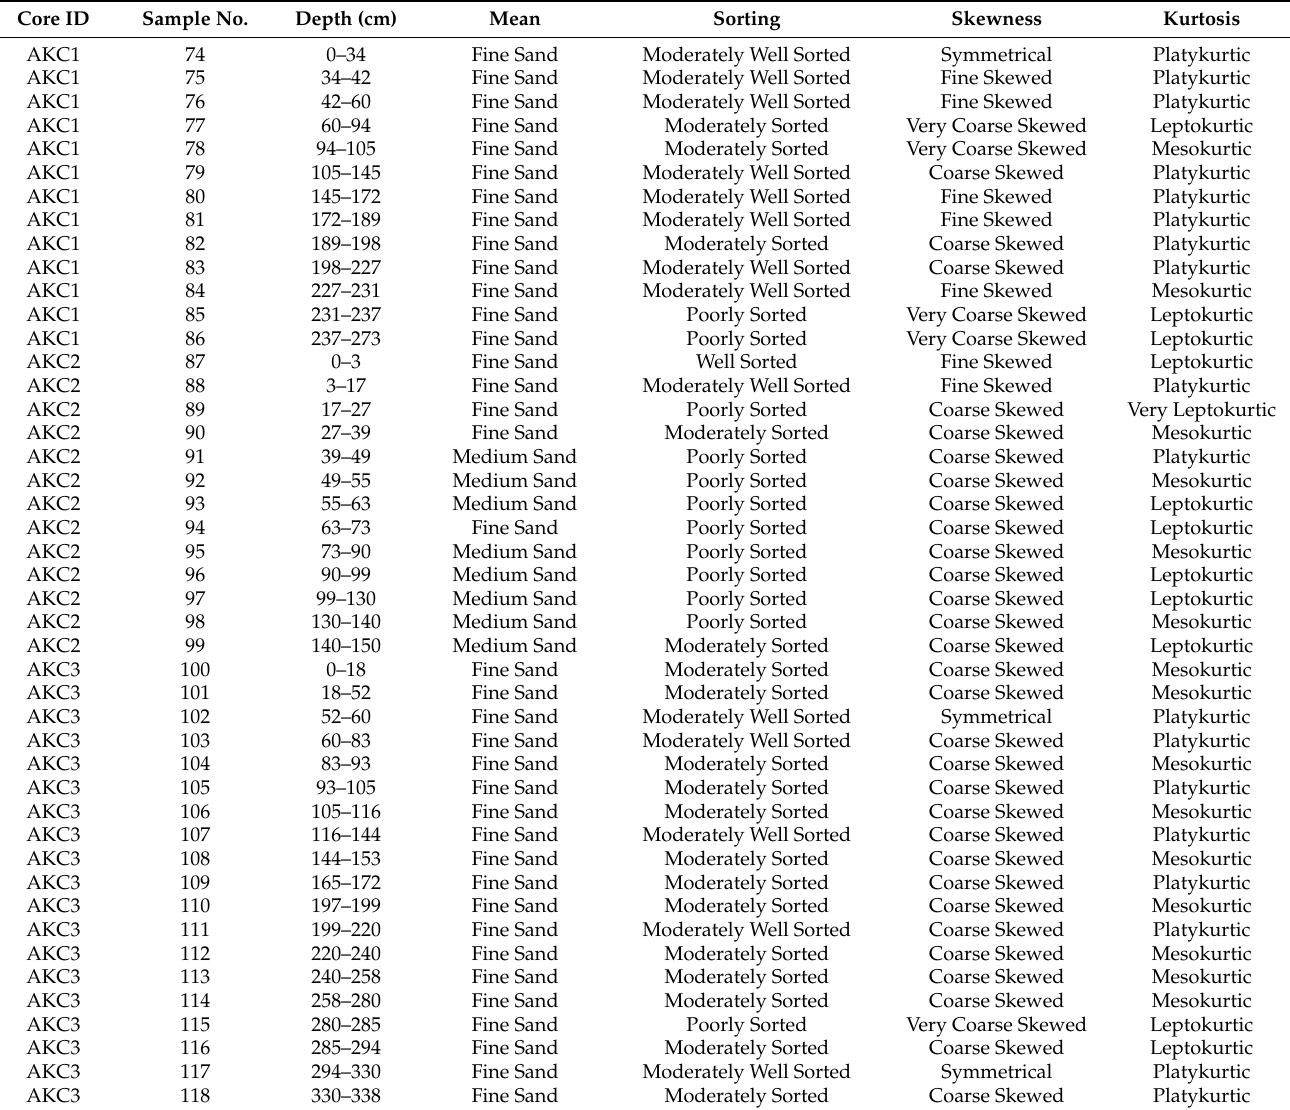
Table 1. Sedimentological statistics, mean, sorting, skewness, and kurtosis calculated using Gradistat V.4 software [69]. Core ID Sample